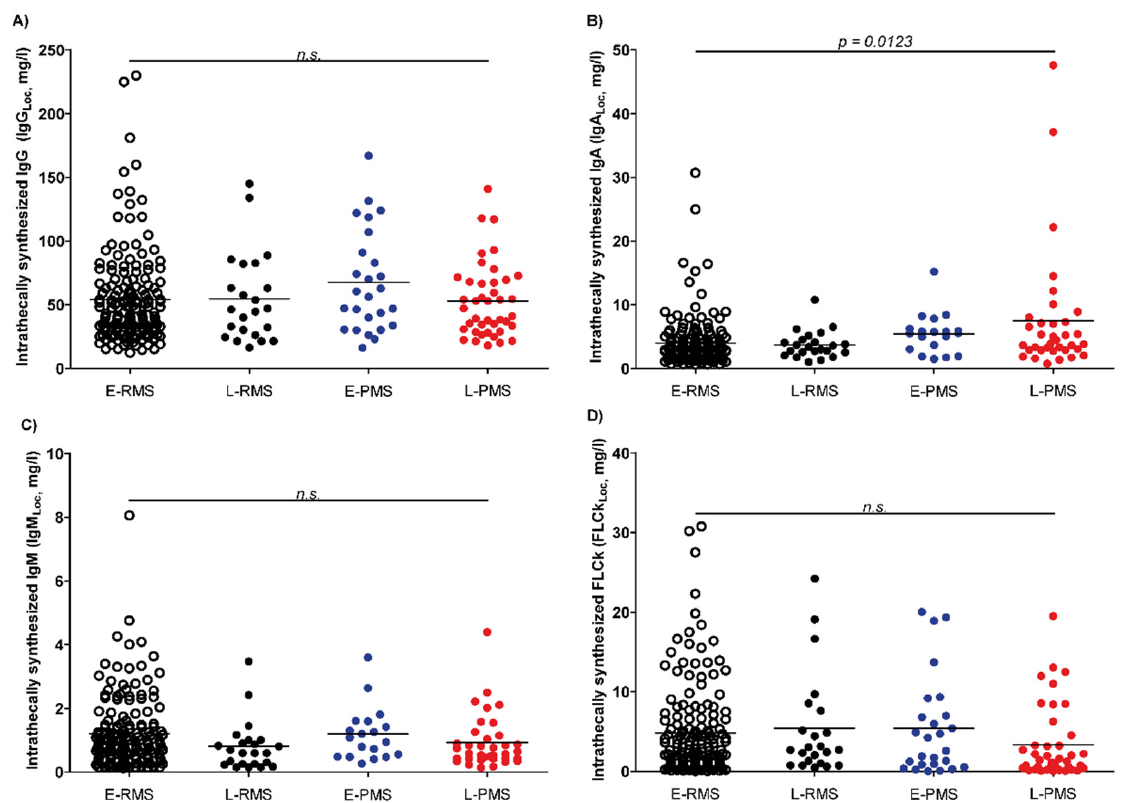
Figure 3. Levels of intrathecally synthesized IgG ( A ), IgA ( B ), IgM ( C ) and free light chains kappa; FLCk ( D ) given as local concentrations. Loc = Local concentration, E-RMS = early onset relapsing multiple sclerosis, L-RMS = late onset relapsing multiple sclerosis, E-PMS = early onset progressive multiple sclerosis, L-PMS = late onset progressive multiple sclerosis, and n.s. = not statistically significant. Overall, the p -value in ( B ) is statistically significant. Comparison between early onset and late onset RMS and PMS was not statistically significant (early versus late RMS: p = 0.4769; early versus late PMS: 0.6638). Comparison of early onset RMS and PMS, as well as late onset RMS and PMS, was statistically significant for early, as well as late, onset MS (early onset MS: p = 0.0073; late onset MS: p = 0.0077).